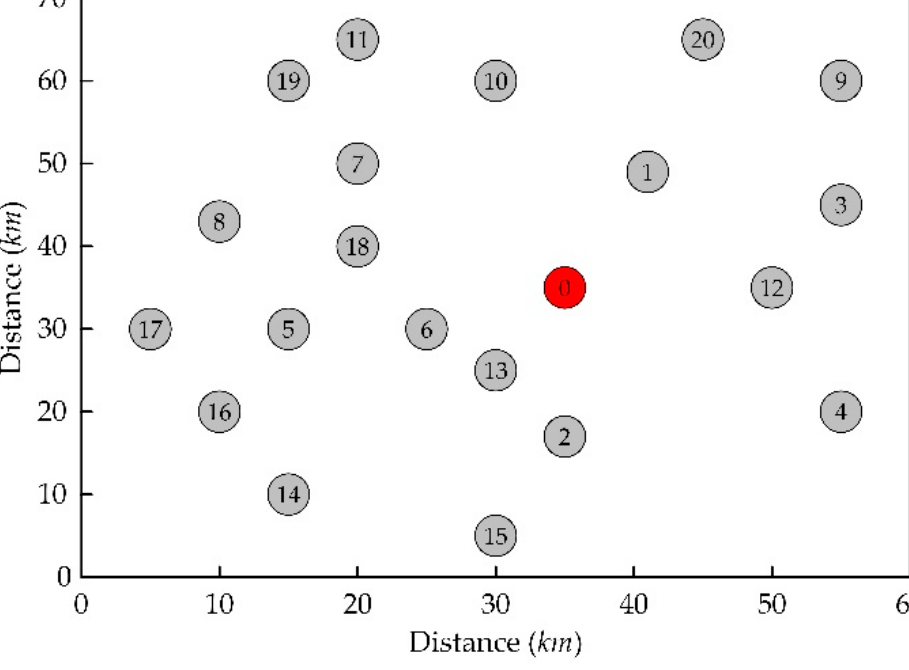
Table 4. Consumer order information.